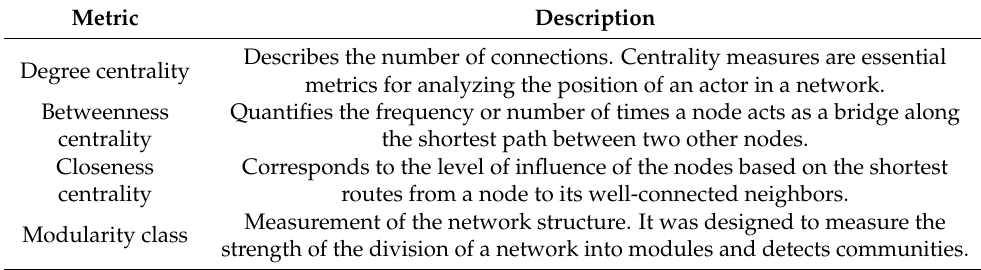
Table 3. Description of metrics used in network analysis. Adapted from [39].